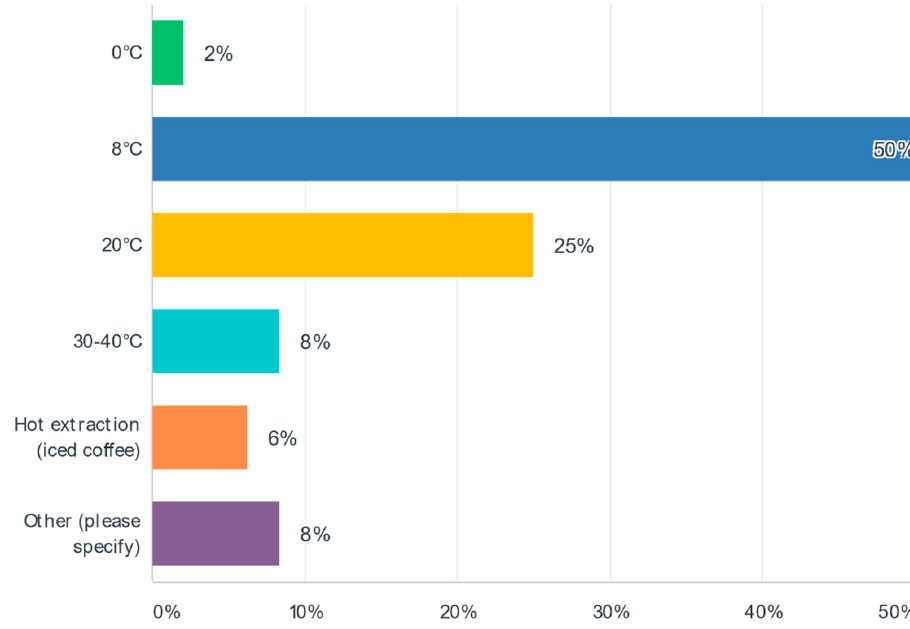
Figure 7. Initial survey result of cold brew extraction temperatures.